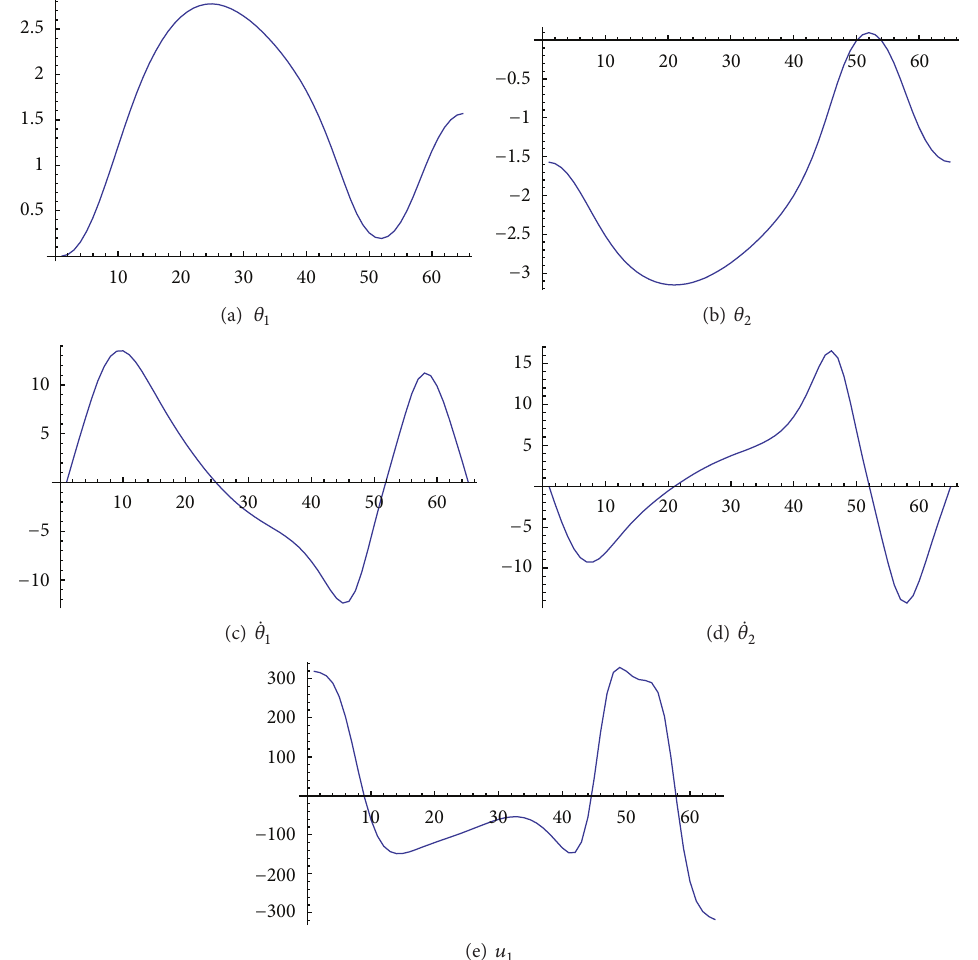
Figure 3: Control and state variables of the optimal solution of problem 1, a boundary value problem for the planar 𝑅𝑅 robot manipulator with boundary conditions 𝜃 1 (𝑡 𝐼 ) = 0[ rad ] , 𝜃 2 (𝑡 𝐼 ) = −𝜋/2 [ rad ] , ̇𝜃 (𝑡 ) = free, and ̇𝜃 1 𝐹 configurations of the robot manipulator at times 𝑘(1/32) with 𝑘 = 0, 1,. . . , 32 is represented in Figure 2.